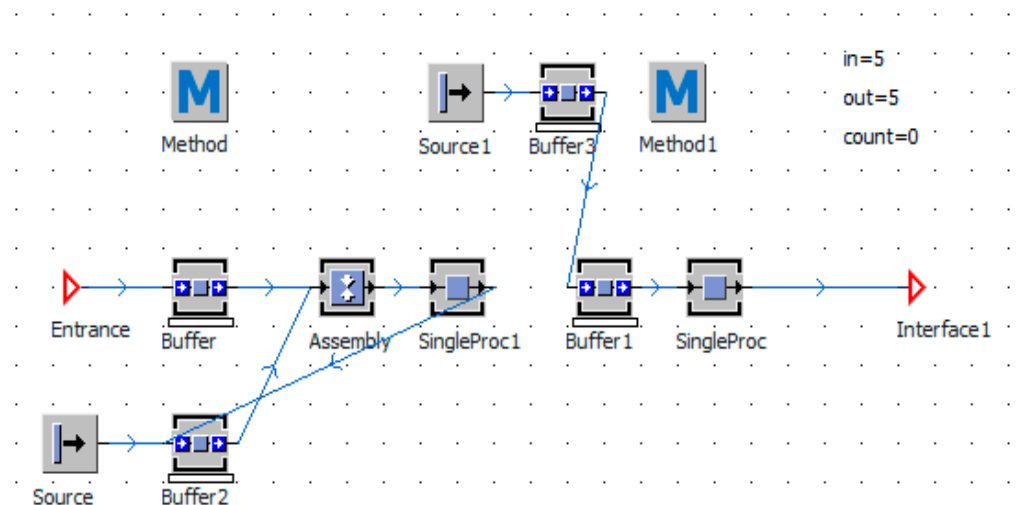
Electronics 2020 , 9 , x FOR PEER REVIEW Figure 4. Automatic assembly system simulation module in plant simulation. Figure 4. Automatic assembly system simulation module in plant simulation.